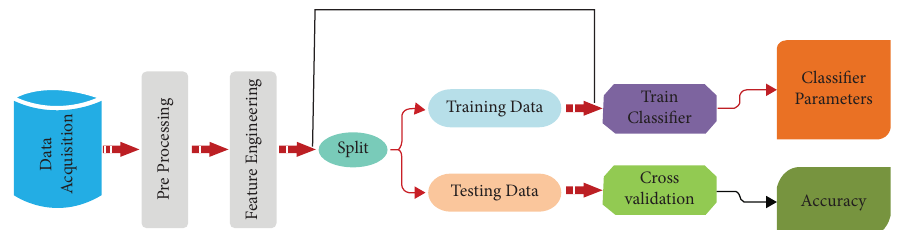
Figure 1: Classical machine learning system for automated epileptic seizure